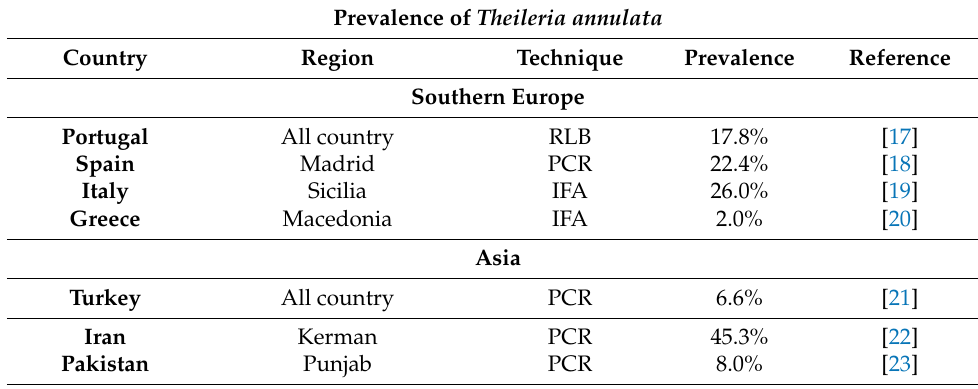
Table 1. Prevalence of Theileria annulata in different countries in Southern Europe, Asia, and